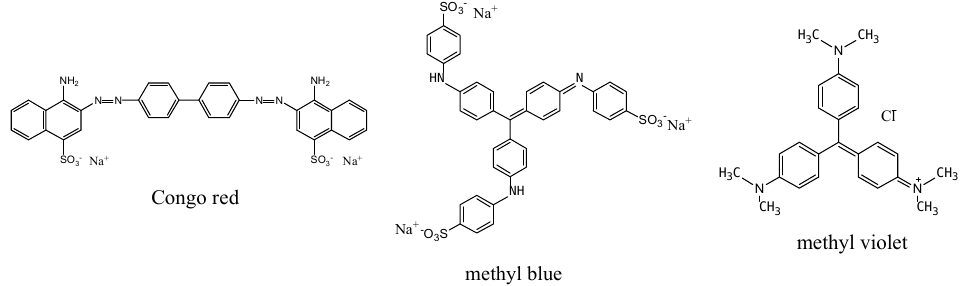
Figure 1. The chemical structures of the three dyes used in this study.